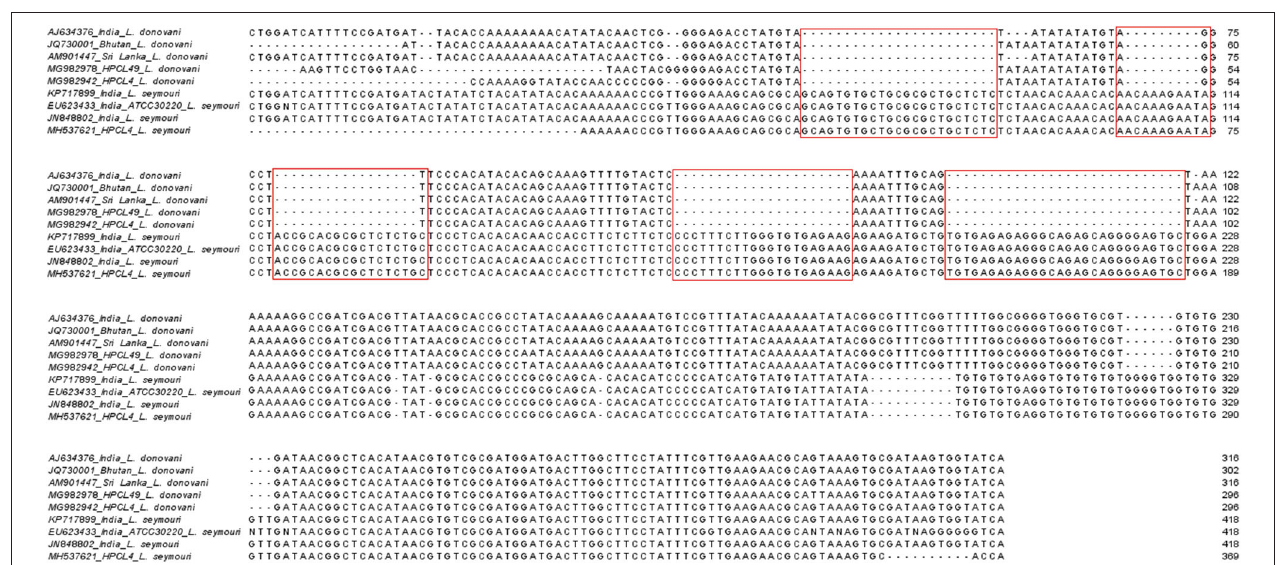
FIGURE 3 | Multiple sequence alignment of ITS1 sequences representing Leishmania specific ∼ 320 bp band ( MG982942_HPCL4_L. donovani and MG982978_HPCL49_L. donovani ) and Leptomonas specific ∼ 400 bp band ( MH537621_HPCL4_L. seymouri ) along with standard L. donovani and L. seymouri specific ITS1 sequences retrieved from Genbank ( AJ634376_India_ L.‘ donovani , JQ730001_ Bhutan _L. donovani , AM901447_Sri Lanka_ L. donovani , KP717899_ India_L. seymouri, EU623433_India_ ATCC30220_L. seymouri and JN848802_India_ L. seymouri ). Sequences were aligned using the Jalview sequence alignment program. Differences in L. donovani and L. seymouri ITS1 sequences are highlighted in